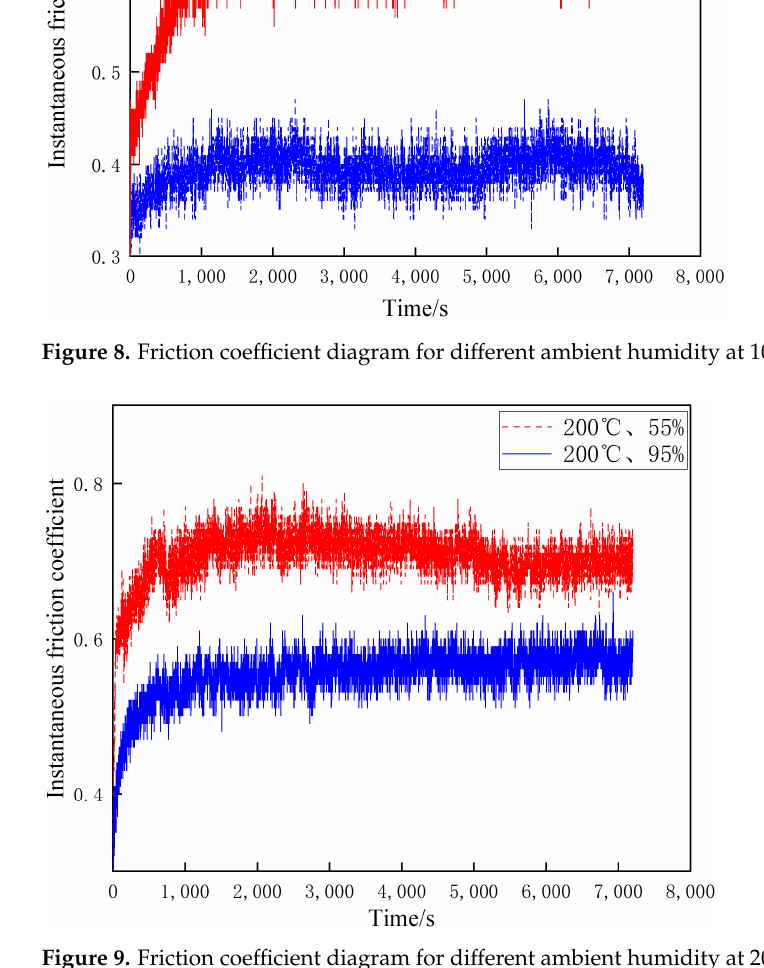
Figure 9. Friction coefficient diagram for different ambient humidity at 200 °C.